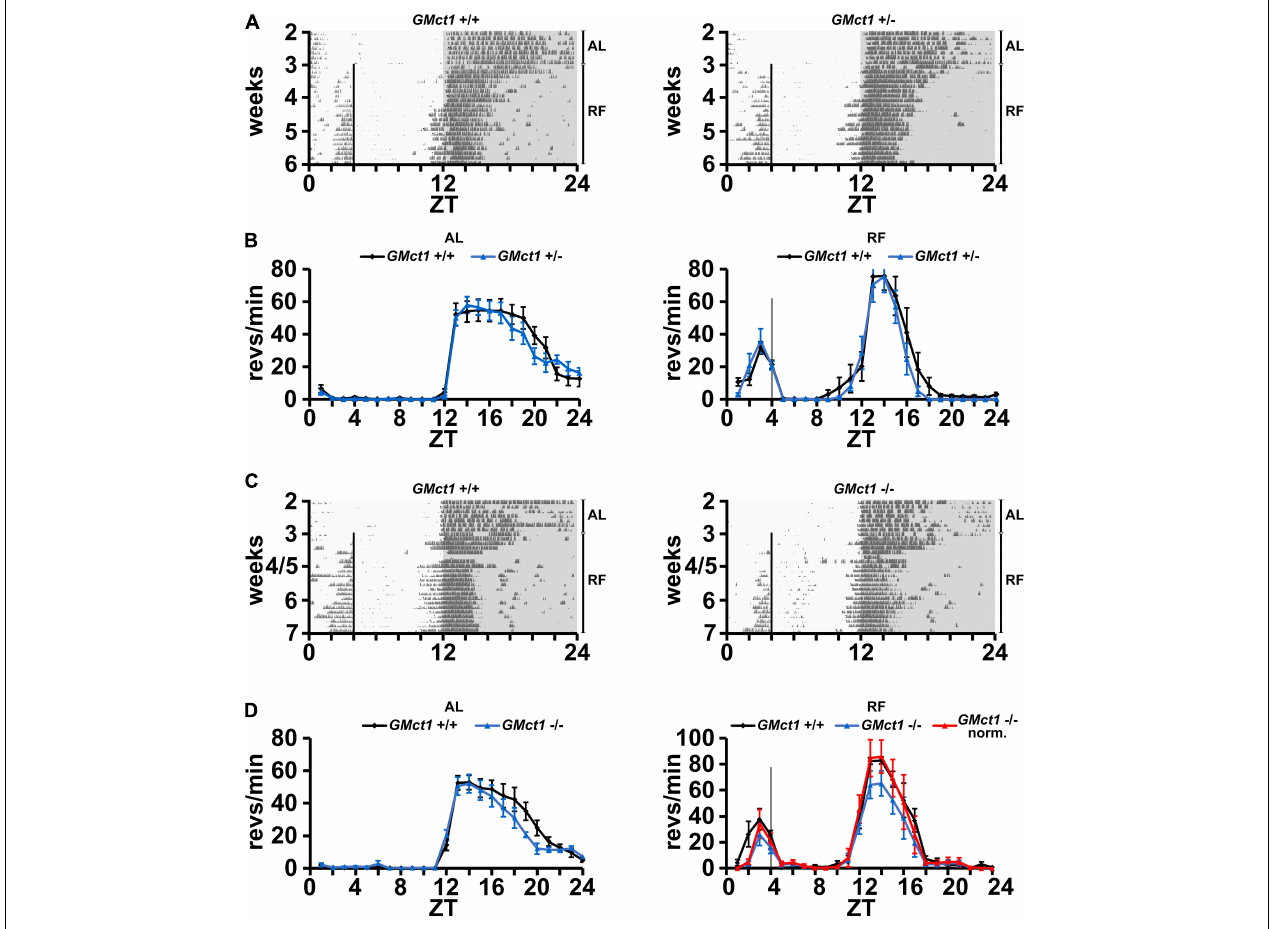
FIGURE 3 | Mice lacking Mct1 in astroglia display normal FAA. (A) Examples of wheel-running actograms of glial Mct1 control animals ( GMct1 + / + , left panel) and heterozygous glial Mct1 knock-out animals ( GMct1 + / − , right panel) under ad libitum (AL) and the last week of daytime-restricted feeding (RF) conditions. The vertical line at ZT4 indicates the time of food access. (B) Quantified wheel-running activity plots under AL (left panel) and RF (right panel) conditions. Food anticipatory activity (FAA) under RF is normal in GMct1 + / − (blue) compared to GMct1 + / + mice (black) ( n = 6, 2-way ANOVA, p > 0.05). (C) Examples of wheel-running actograms of glial Mct1 control animals ( GMct1 + / + , left panel) and homozygous glial Mct1 knock-out animals ( GMct1 − / − , right panel) under ad libitum (AL) and day time restricted feeding (RF) conditions. The vertical line at ZT4 indicates the time of food access. (D) Quantified wheel-running activity plots under AL (left panel) and RF (right panel) conditions. Food anticipatory activity (FAA) under RF is normal in GMct1 − / − (blue) and normalized GMct1 − / − (red) compared to GMct1 + / + mice (black) ( n = 4–7, 2-way ANOVA, p > 0.05). Error bars represent the standard error of